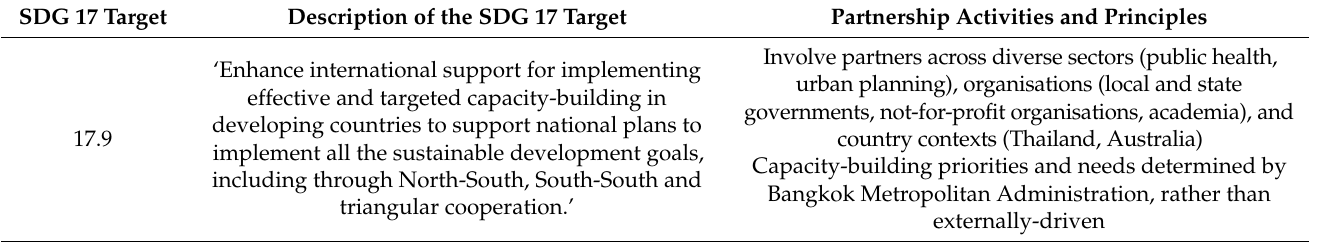
Table 1. Partnership activities and principles in the context of SDG 17